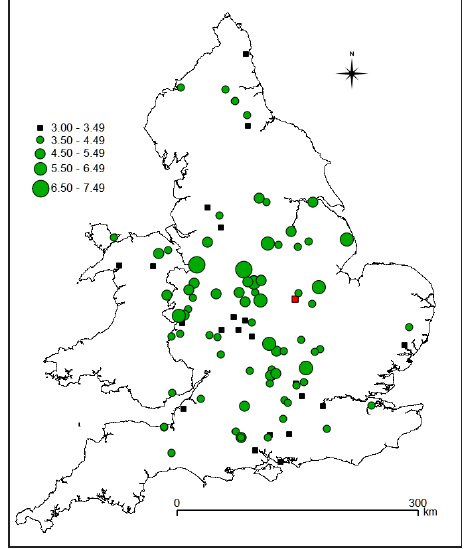
Figure 2: Map of England and Wales showing levels of statistical agreement